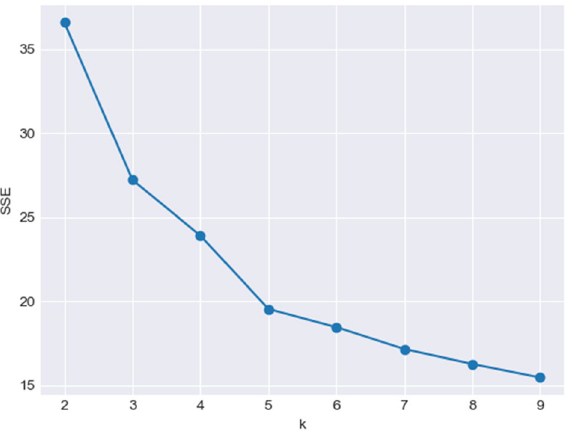
Figure 2. Elbow method and parameter K for the K-Means